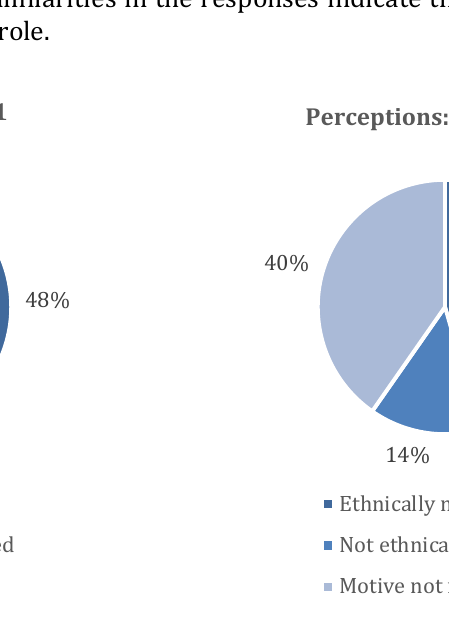
Figure 5: Perceptions of motivation for the attack in Articles 1 and 2